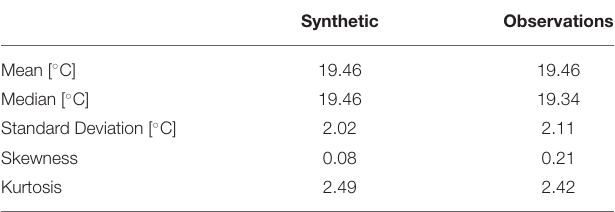
TABLE 2 | The mean, median, standard deviation, skewness, and kurtosis for the synthetic and observed temperature overall distributions between 1953 and 2019 at depths between 17 and 21m.